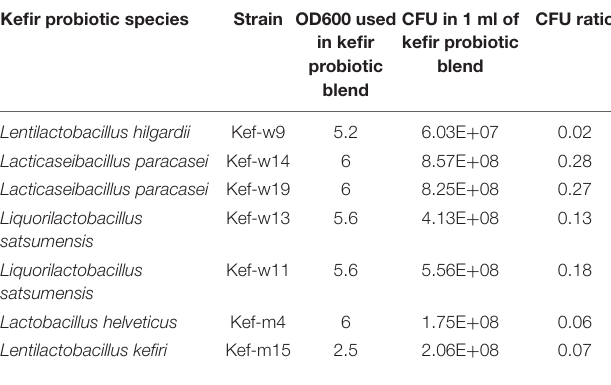
TABLE 2 | Composition of kefir “probiotics